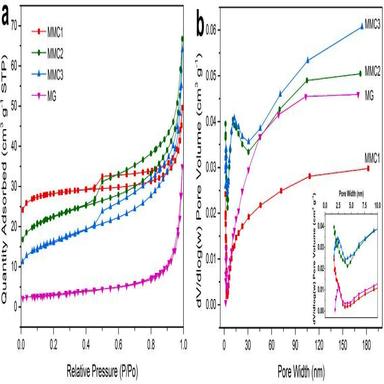
(a) Nitrogen adsorption-desorption isotherms and (b) BJH pore size distribution for the volume of MG and MMC support (inset in (b) is the high magnification image).